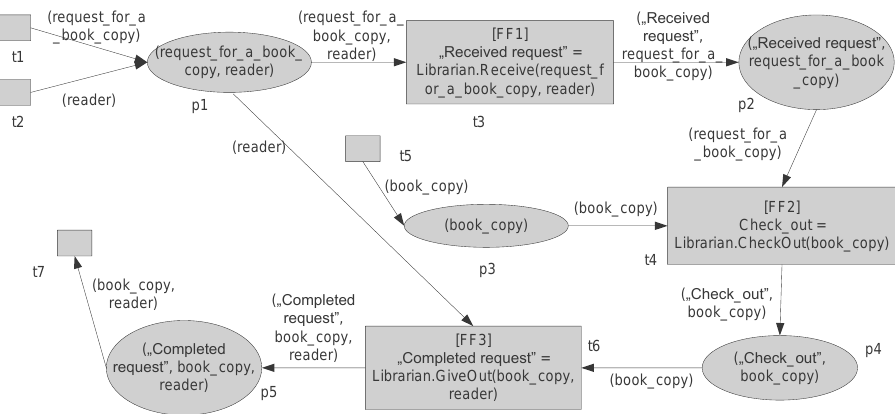
Fig. 7. The example of CP Net mapped from the TFM